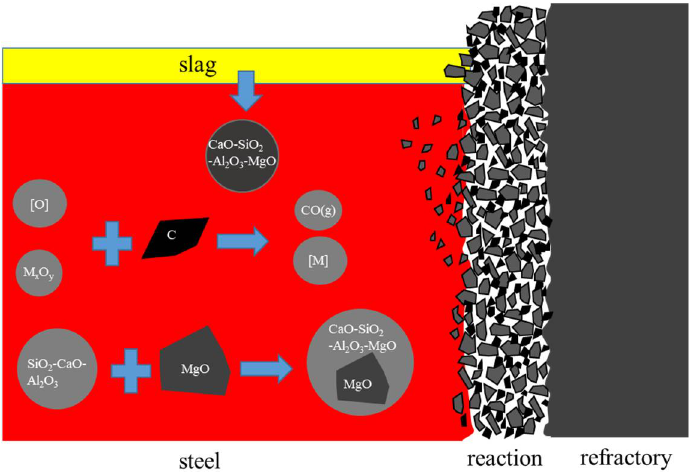
Figure 13. Illustration diagram of steel-slag-refractory interaction mechanism.